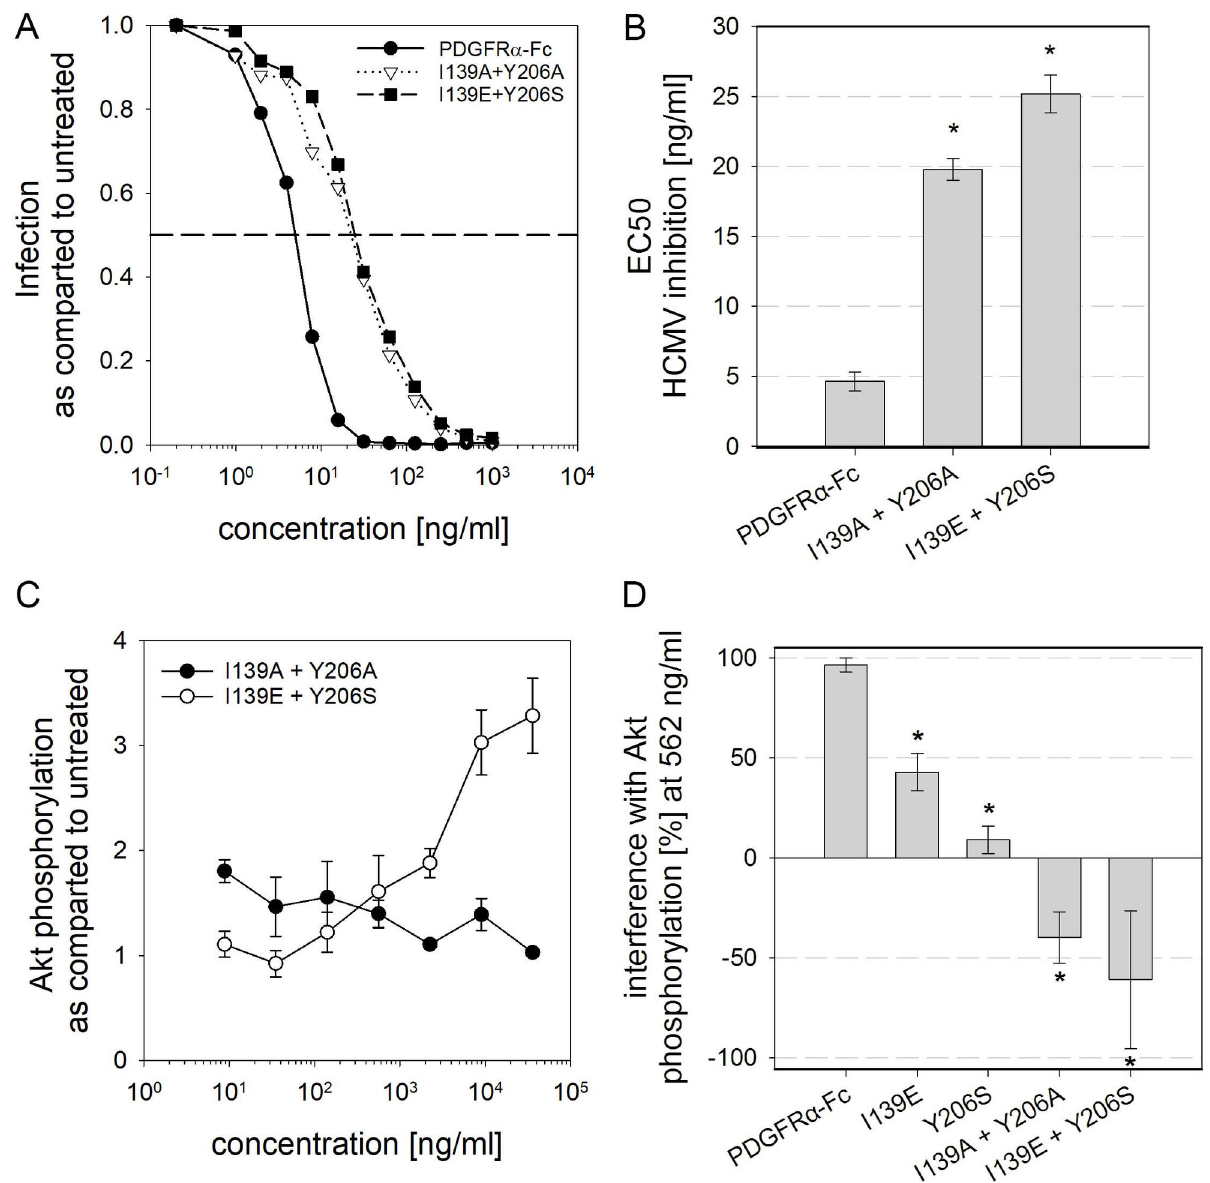
Fig 6. Combination of multiple amino acid exchanges in PDGFR α further reduces inhibition of PDGF dependent signaling. A + B: Quantification of HCMV inhibition by PDGFR α -Fc double amino acid exchange mutants. To measure the inhibition of infection, the rate of immediate early antigen-positive cells after infection with HCMV untreated or pretreated with PDGFR α -Fc was measured. An average of 3 independent dose-response experiments is shown in A . The corresponding EC50 values are shown in B . C + D : PDGF-dependent signaling after preincubation of 6 ng/ml PDGF-BB with various concentrations of PDGFR α -Fc mutants was quantified with a phospho-Akt ELISA. The dose- response curves shown in C depict the mean of 3 independent experiments and D compares the interference of 562 ng/ml of the different PDGFR α - Fcs with PDGF-dependent cellular signaling. 100% interference equals complete inhibition of Akt phosphorylation to the level of unstimulated cells whereas negative values indicate enhanced Akt phosphorylation as compared to cells that were stimulated with untreated PDGF-BB. All error bars indicate standard error of the